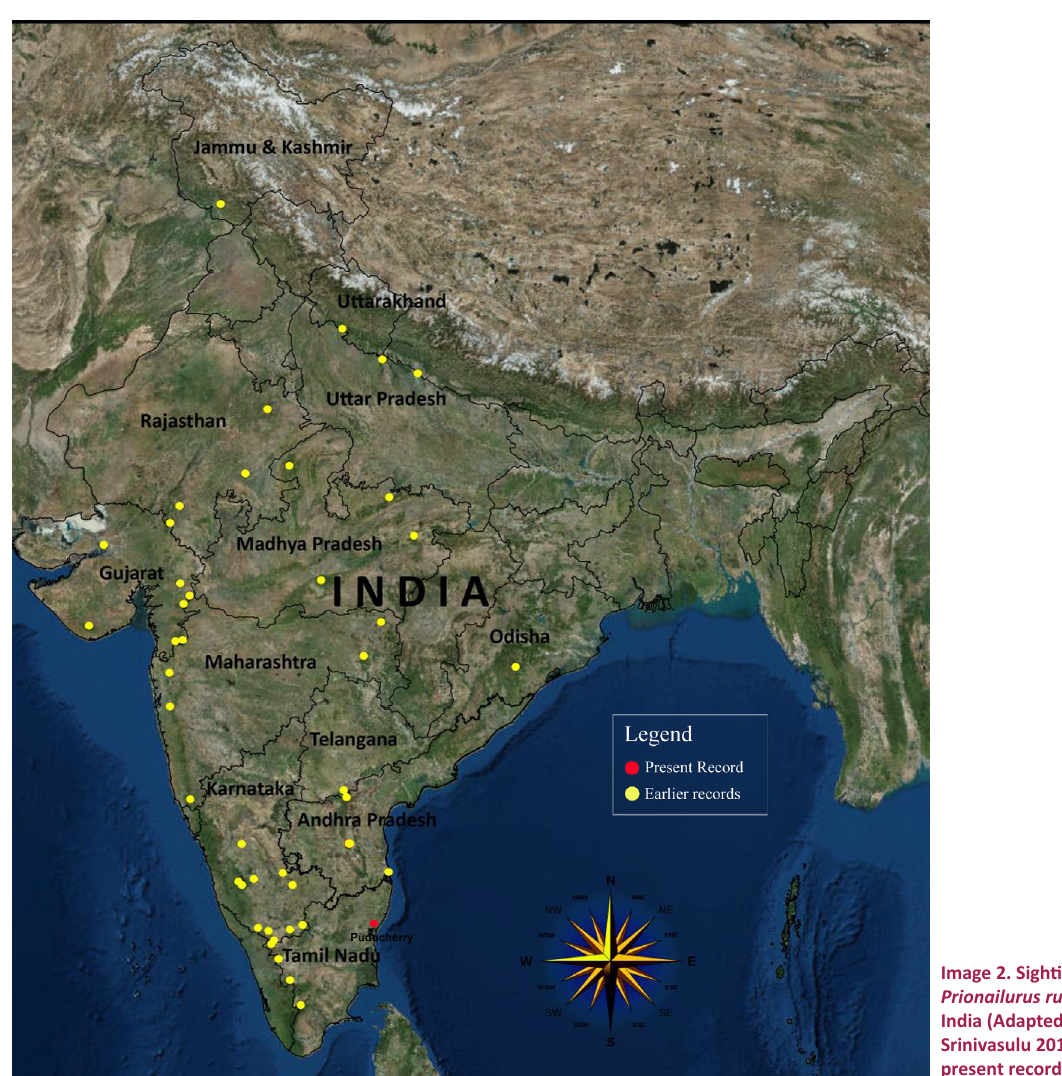
Image 2. Sightings of Prionailurus rubiginosus in India (Adapted from Mali & Srinivasulu 2015) and the present